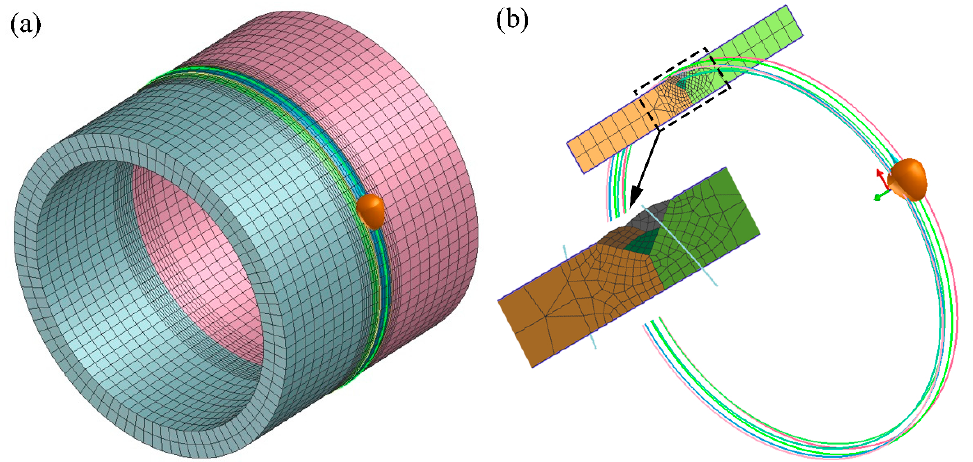
Figure 3. Schematic diagram of verification model: ( a ) 3D model, ( b ) 2D rotational model.